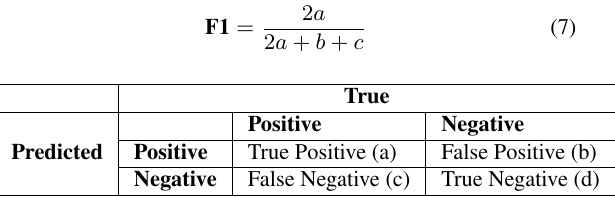
Table 5. Confusion Matrix